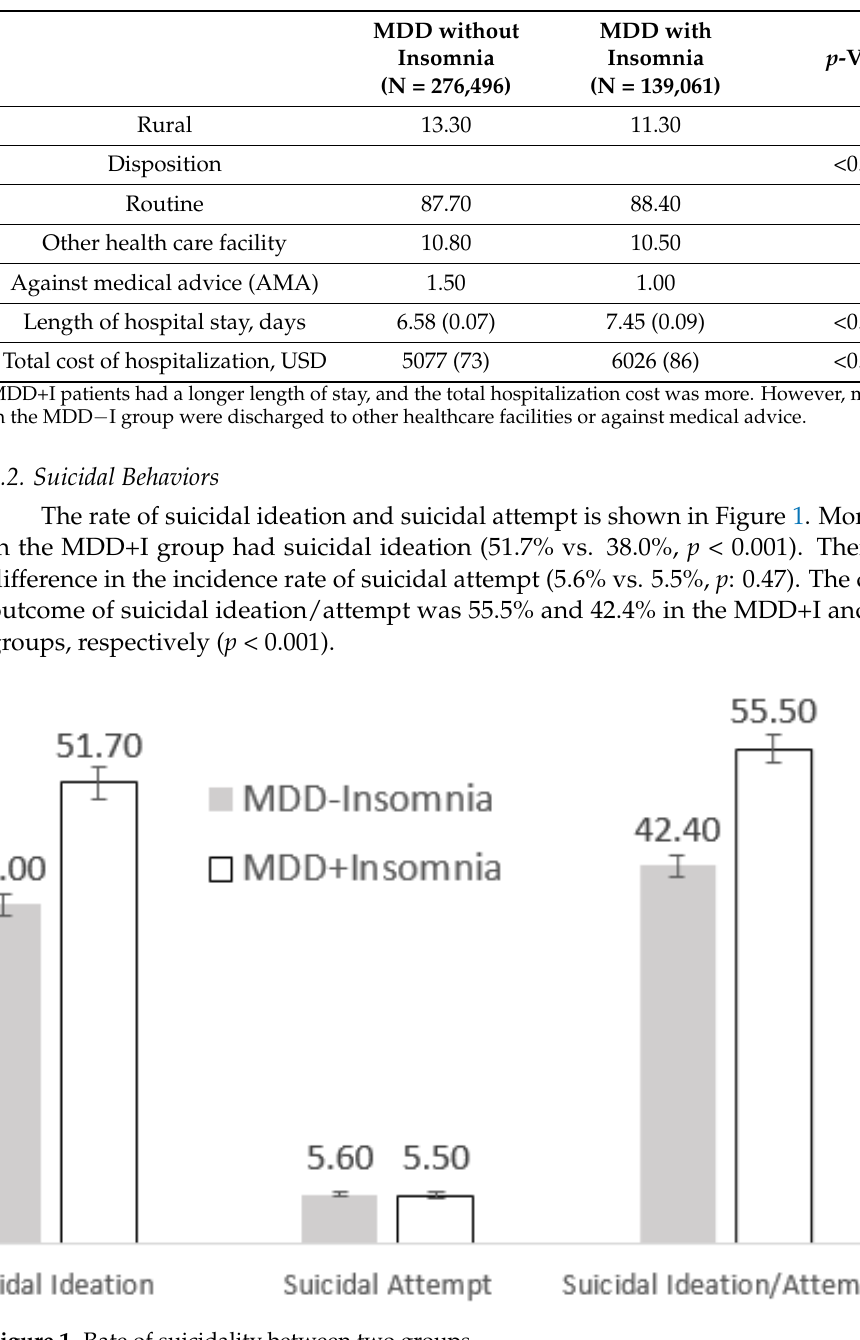
Table 2. Predictors associated with suicidal ideation/attempt among study population